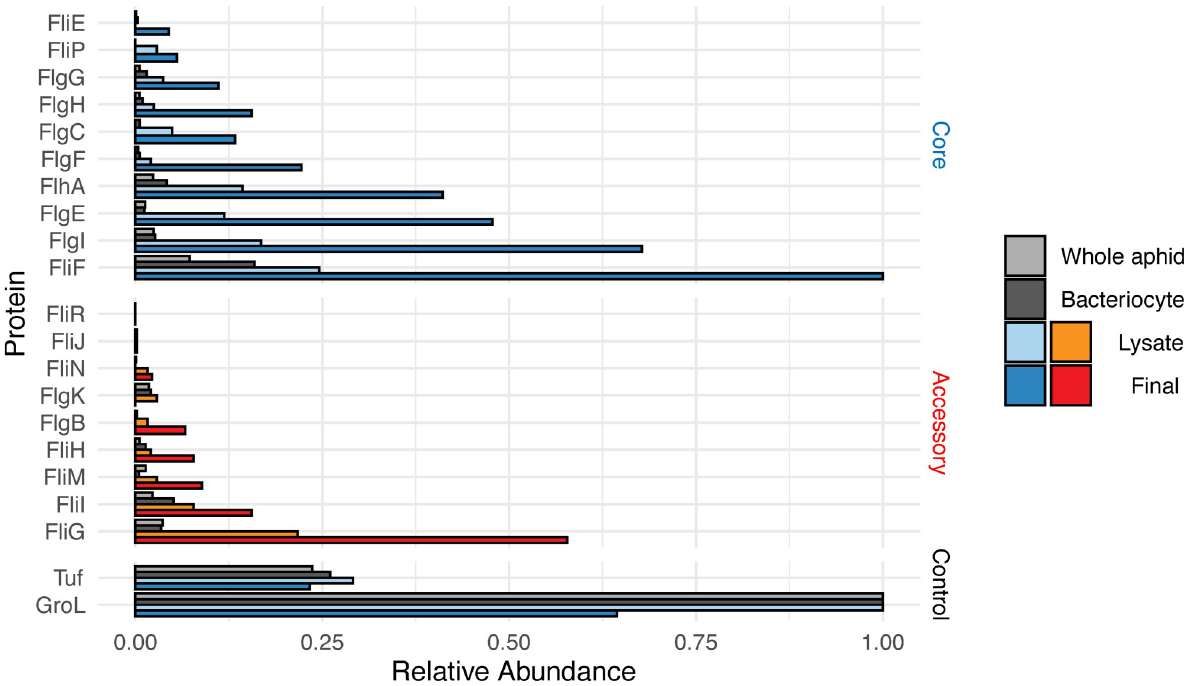
Fig 2. Barplot showing enrichment of flagellum-related proteins before (Lysate) and after (Final) the isolation procedure. Results from the protein enrichment procedure are compared to proteomic datasets generated with whole aphids and dissected bacteriocytes. Blue indicates “core” proteins required for secretion activity and red indicates accessory proteins maintained by Buchnera aphidicola in pea aphids.